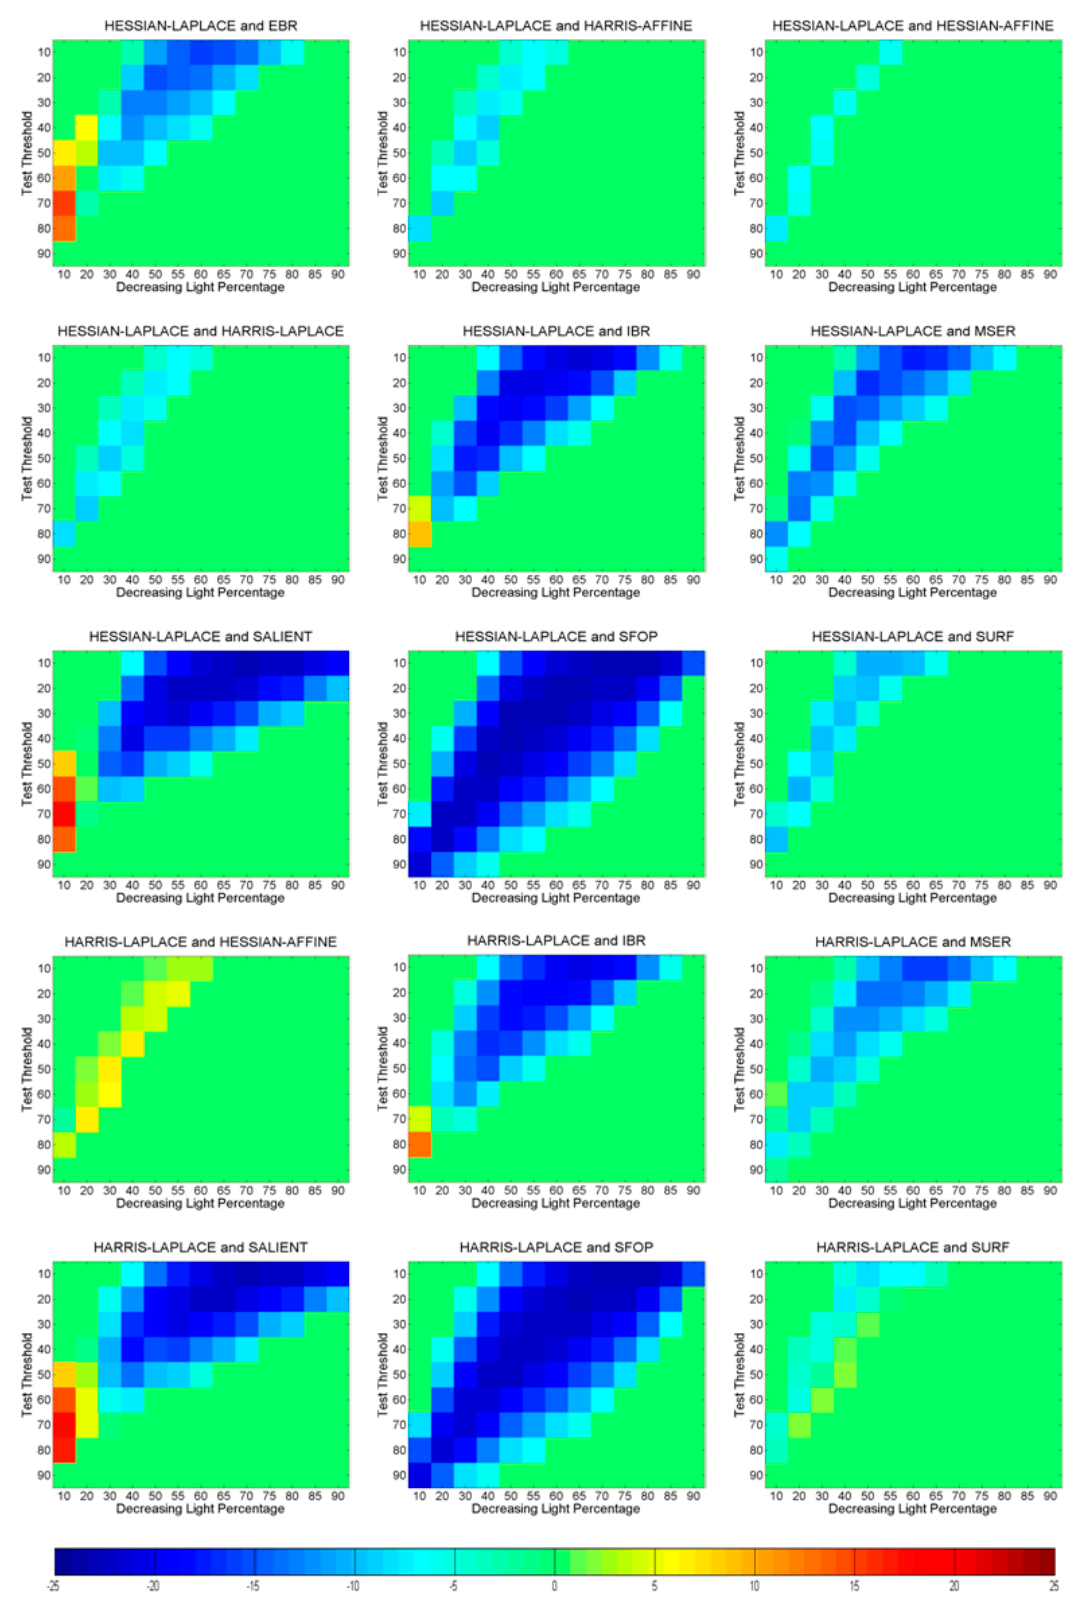
Figure 16. Results of uniform light changes for Harris-Laplace and Hessian-Laplace with other detectors showing Z -scores obtained; positive Z -scores indicate that the first detector is better than the second whereas negative values show the converse.